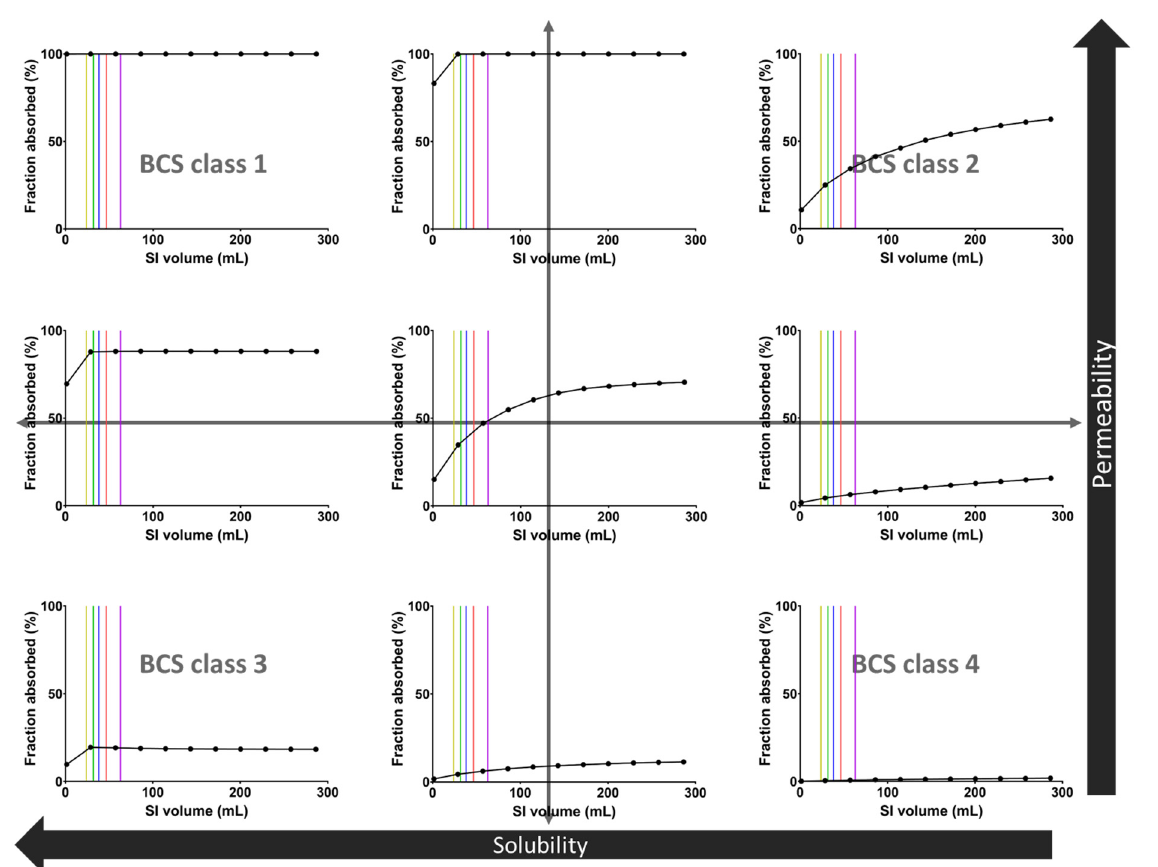
Figure 6. Sensitivity analysis of the fraction absorbed of 9 hypothetical drugs as a function of the fluid volume in the SI. Vertical lines indicate the median SI fluid volumes for the different pediatric subpopulations: yellow = infant, green = toddler, blue = preschool child, red = school-age child, purple = adolescent.